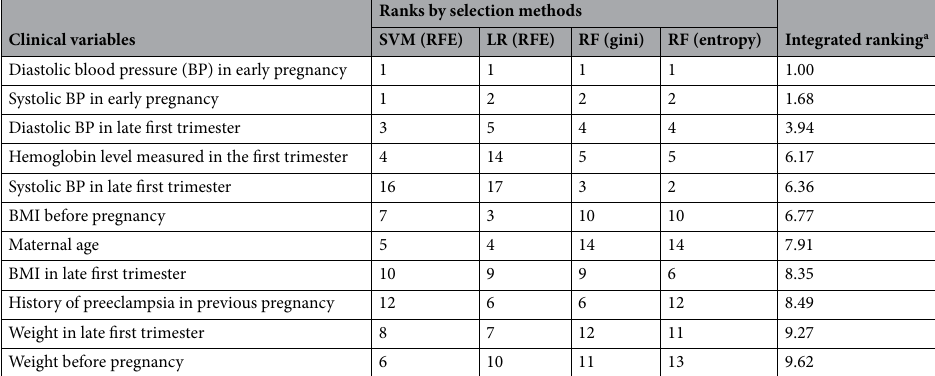
Table 2. Rank of top 11 important variables selected from various machine learning methods; support vector machine with recursive feature elimination (SVM-RFE), logistic regression with recursive feature elimination (LR-RFE), random forest using gini index (RF-gini), and random forest using information entropy (RF-entropy). Early pregnancy, measured at 7.7 ± 1.2 weeks; late first trimester, measured at 12.4 ± 0.5 weeks. BMI body mass index, BP blood pressure. a To combine/aggregate four different rankings, we apply the geometric mean which is defined as (cid:31)(cid:30)